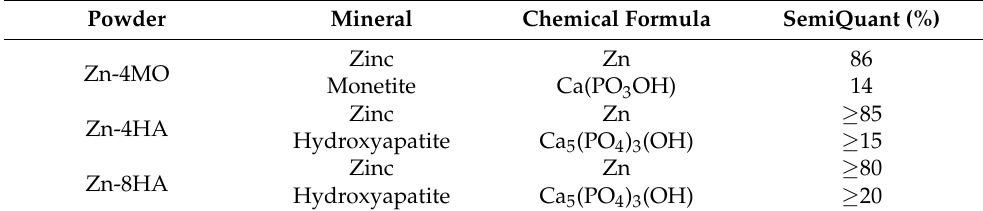
Table 3. Phase composition of the powder mixtures according to XRD.